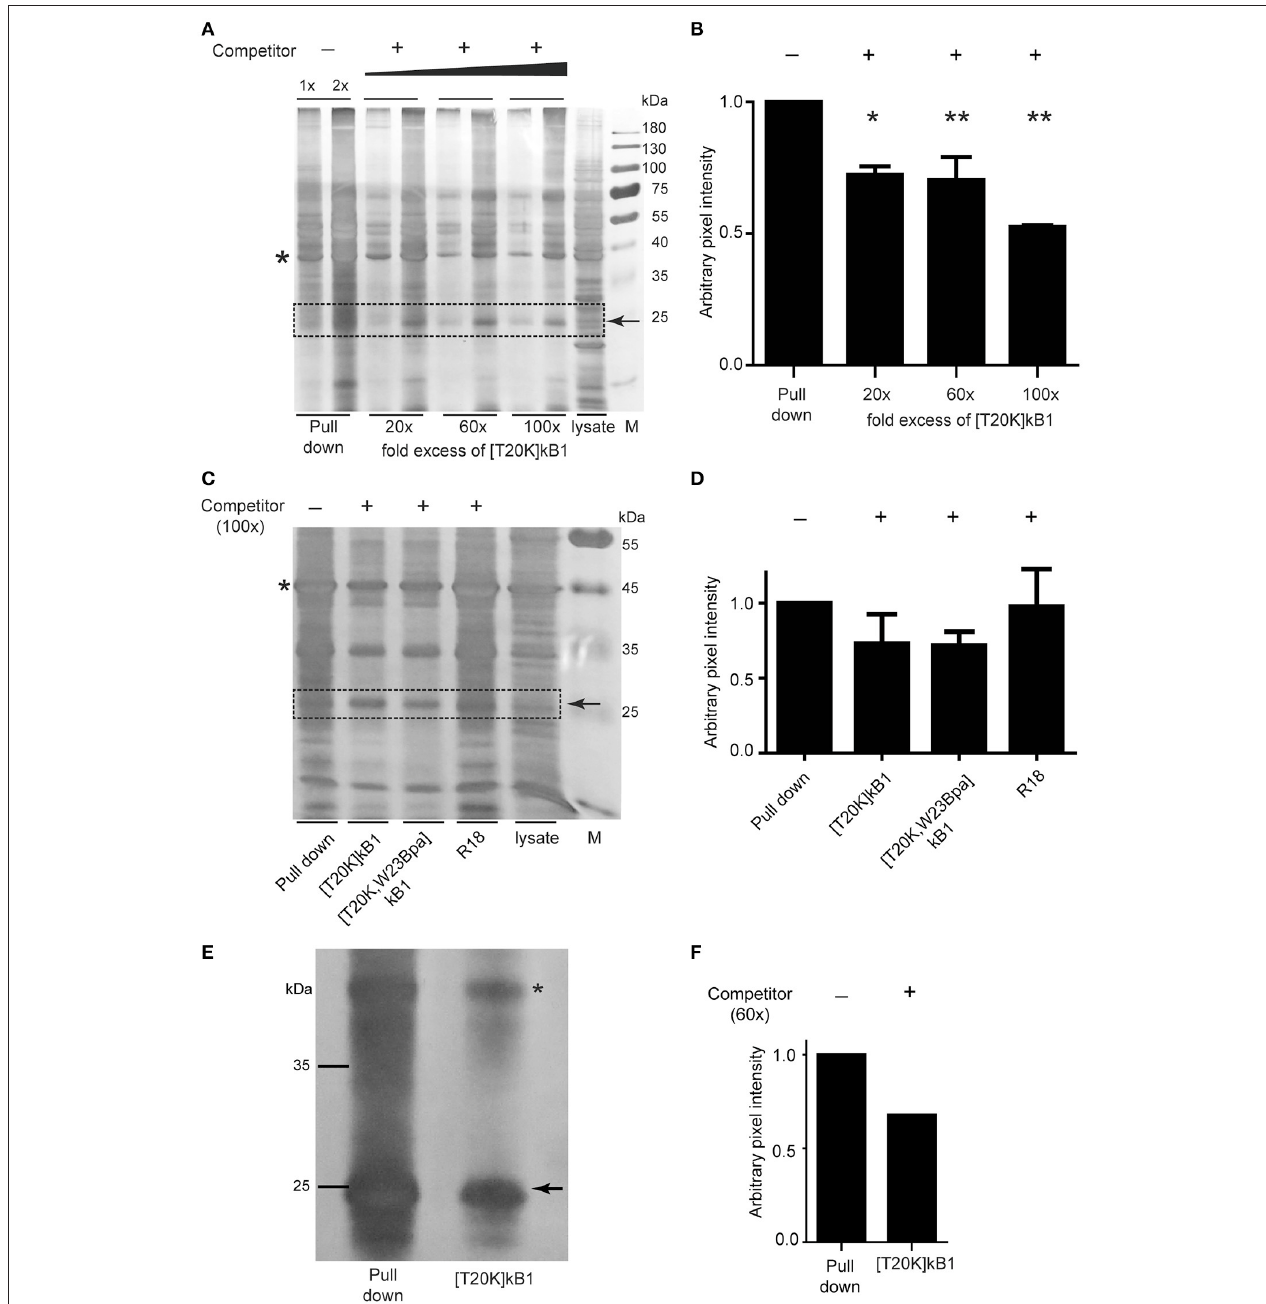
FIGURE 4 | Photo-affinity capture of binding proteins with cyclotide probes and competitor titration for target identification. (A) Representative silver-stained gel image of Jurkat cell lysates probed with photo-affinity crosslinker [T20K,W23Bpa]kalata B1 (kB1) and pull down via biotin-linker in the absence ( − ) and presence ( + ) of bait competitor [T20K]kB1 at 20-, 60-, and 100-fold molar excess relative to the amount of [T20K,W23Bpa]kB1. (B) Exemplarily, a 25 kDa protein band that was affected in intensity by application of competitor which was semi-quantified relative to the pull down sample via pixel analysis of replicated silver gels using ImageJ. Values were normalized to a random internal loading control indicated with an asterisk. (C) Total soluble protein lysate isolated from MOG immunized mouse splenocytes (EAE disease inductions) were incubated with photo-affinity probe [T20K,W23Bpa]kB1, crosslinked and pulled down, with or without addition of various competitors [T20K]kB1, [T20K,W23Bpa]kB1 and pan-14-3-3 peptide inhibitor R18 (all at 100-fold molar excess). A representative silver stained protein gel is illustrated. (D) Semi-quantitative evaluation of the 25 kDa protein band via pixel analysis as described in (B) . (E) Photo-affinity pull down experiment on living Jurkat cells in cell culture is illustrated via a silver stained protein gel. After 2 h of incubation with bait peptide and with or without the presence of 60-fold excess of competitor [T20K]kB1, the crosslinker was activated by UV-irradiation. Values were normalized to a random internal loading control indicated with an asterisk. (F) Semi-quantitative evaluation of the 25 kDa protein band via pixel analysis as described in (B) .